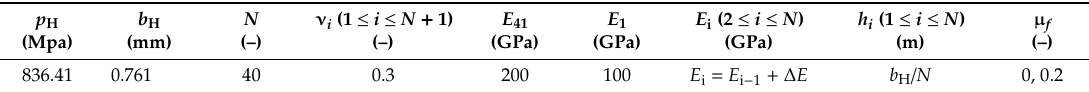
Figure 2. Comparison of the maximum shear stress of a half plane of the substrate material subjected to surface contact loading, ( a ) the exact analytical solution given by McEwen, ( b ) the solution of the present method. Table 2. Input parameters of the present method for simulating the multilayered solid with 40 layers subjected to surface contact loading.